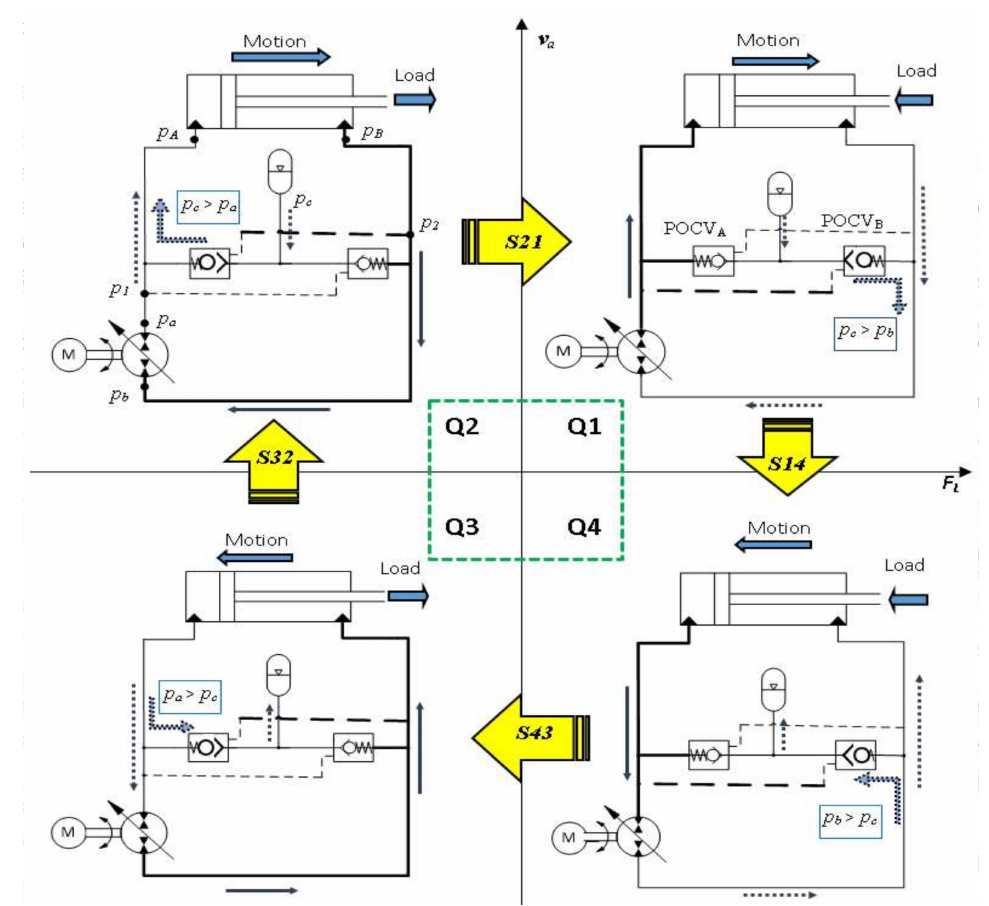
Figure 2. Flow patterns in four quadrants of operation and switching zones of the circuit shown in Figure 1, in the F L − v a